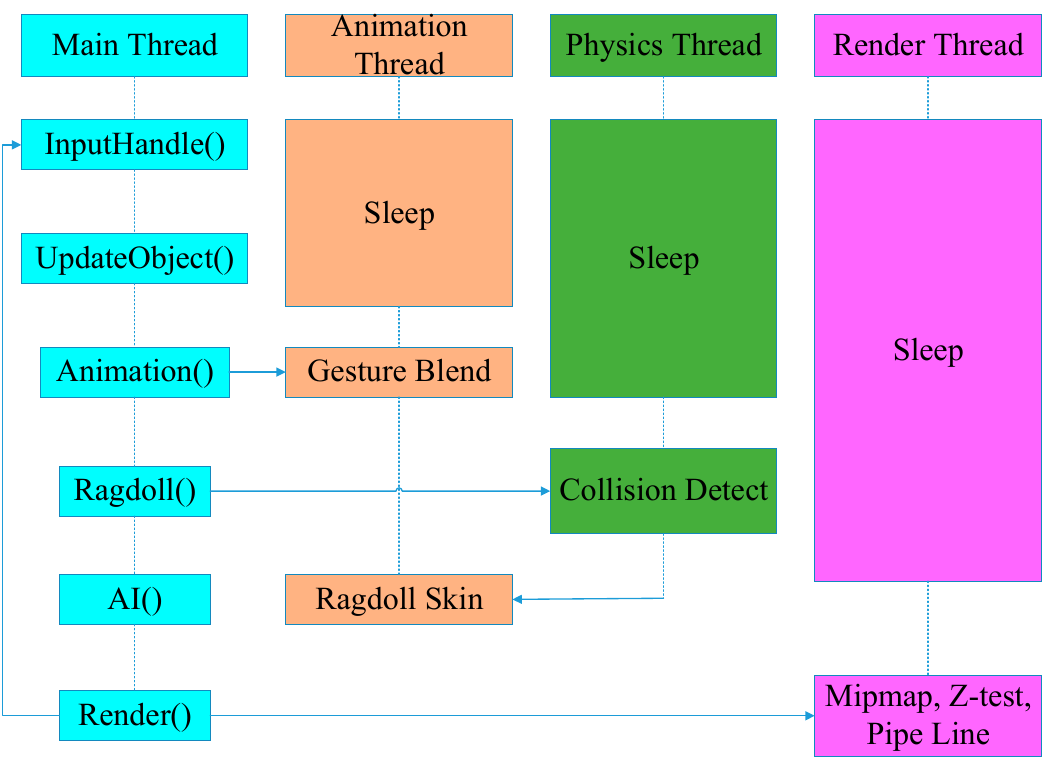
Figure 1. The architecture for multiple threads.